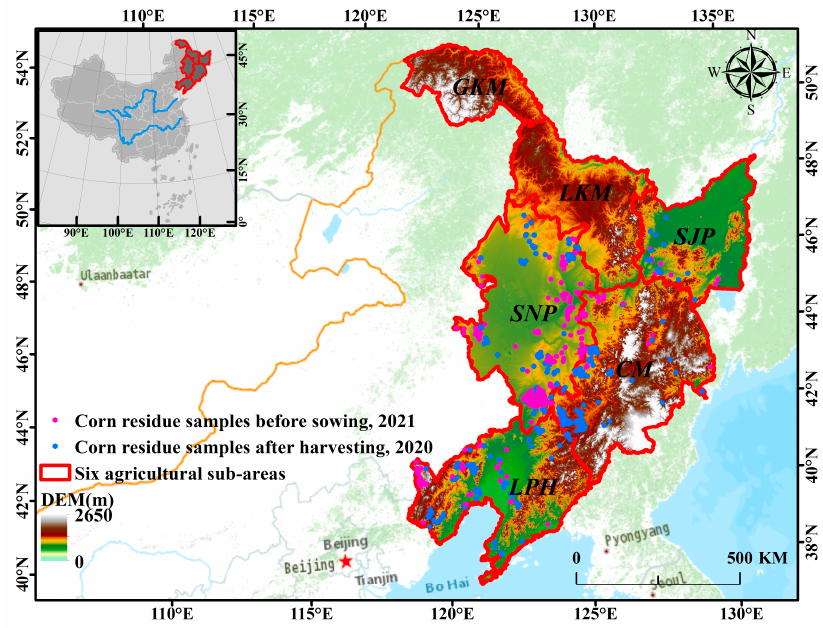
Figure 1. Location, topography, and six agricultural sub-areas of Northeast China.